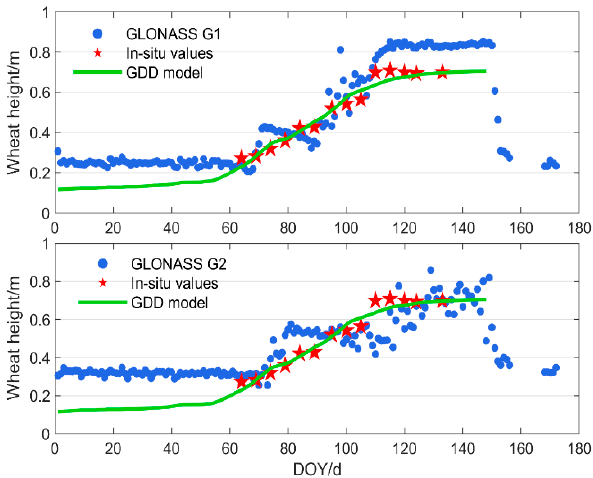
Figure 8. Wheat height retrieval with GLONASS.